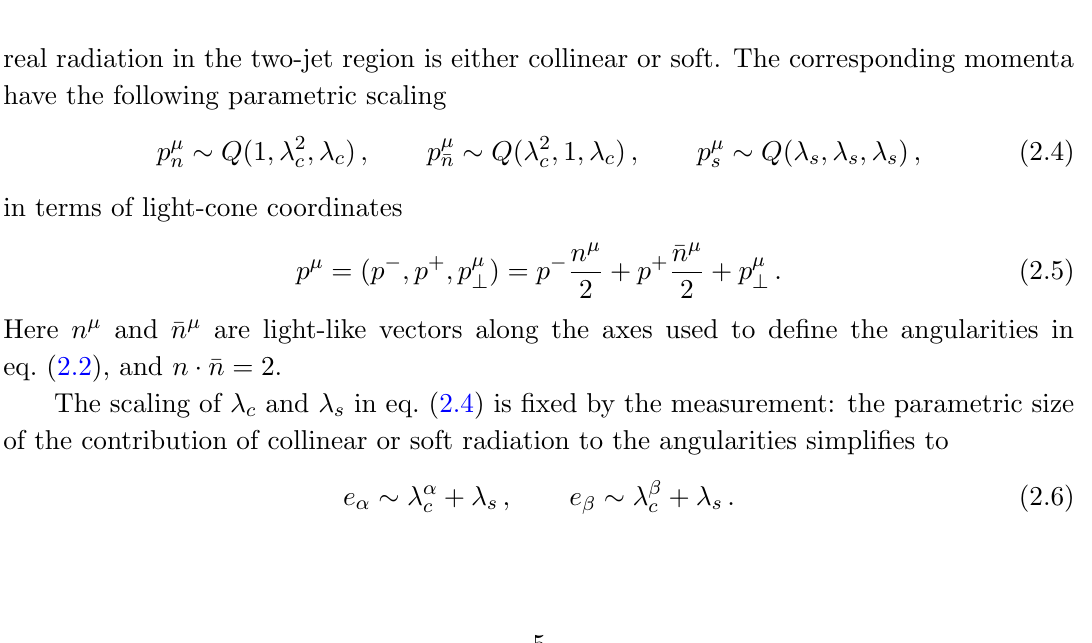
Table 1 . The parametric size of the light-cone components of the momenta ( p (cid:0) ; p + ; p (cid:22) various degrees of freedom in